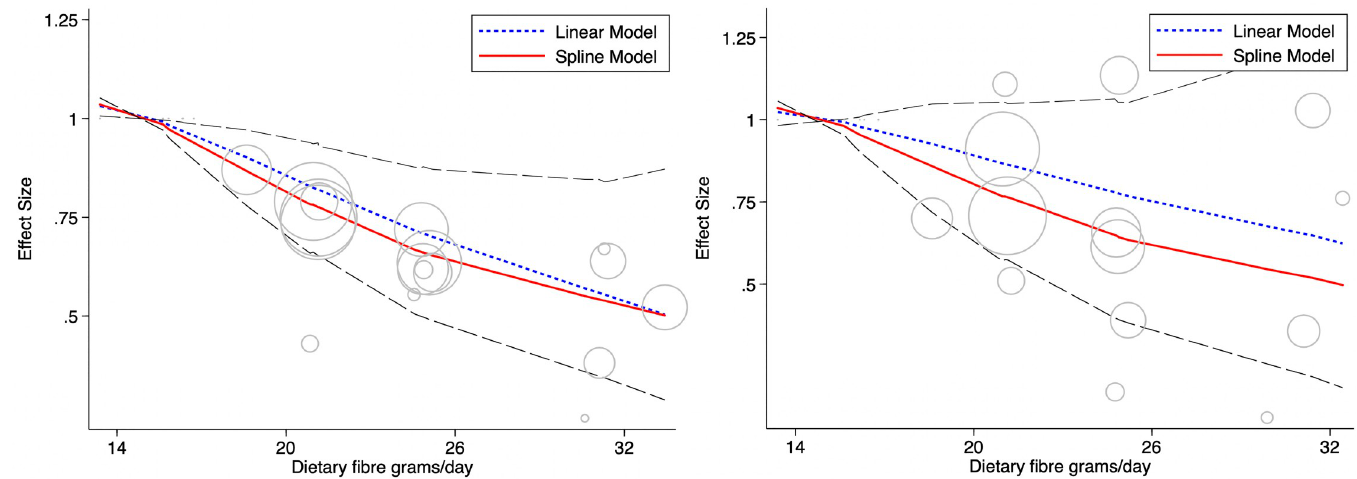
Fig 2. Dietary fibre intake and all-cause (left) and CVD mortality (right) in cohorts with type 1 or type 2 diabetes. The 95% CIs are shown as dashed lines. Cohort data are presented as country specific estimates when possible. Circle size indicates the weighting of each data point, with bigger circles indicating greater influence. CVD, cardiovascular